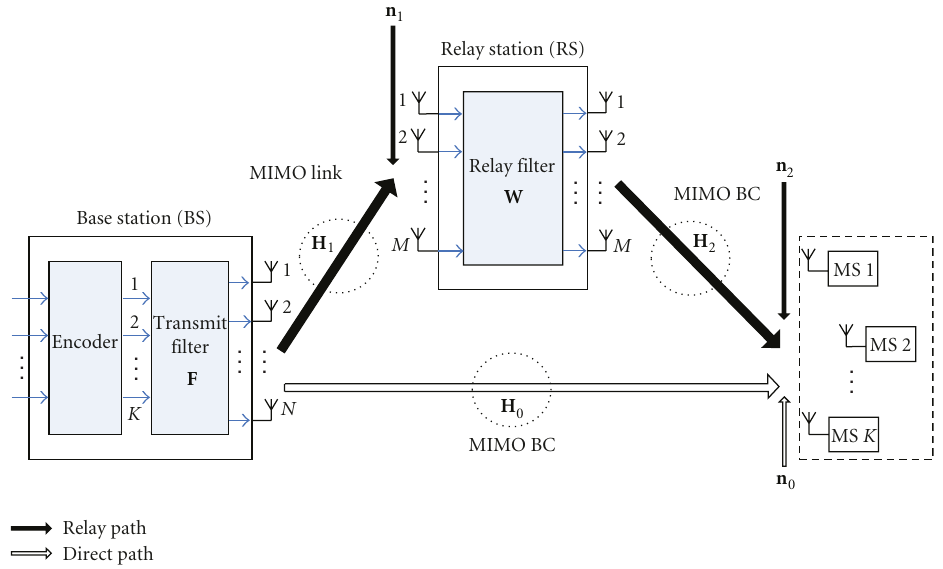
Figure 1: Multiuser cooperative MIMO relay system model in